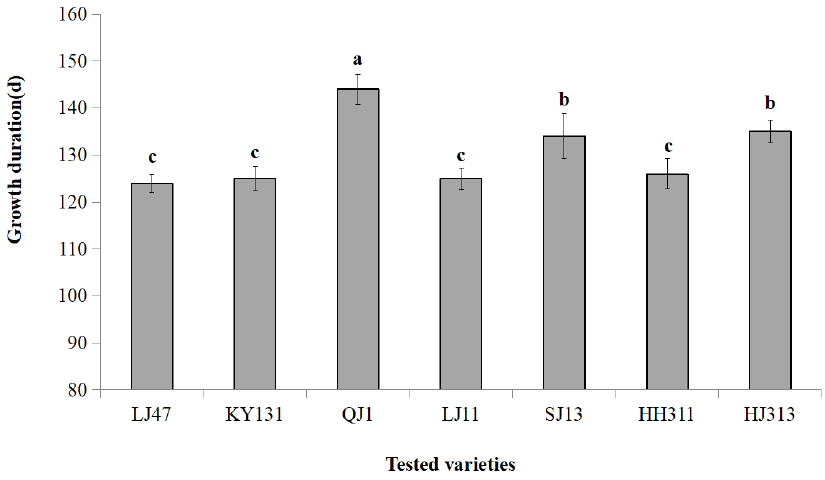
Figure 1. The GD values of 7 tested japonica rice varieties. Values with different superscript letters were significantly different at p < 0.05. The GD refers to the number of days (d) that rice takes from emergence to maturity.